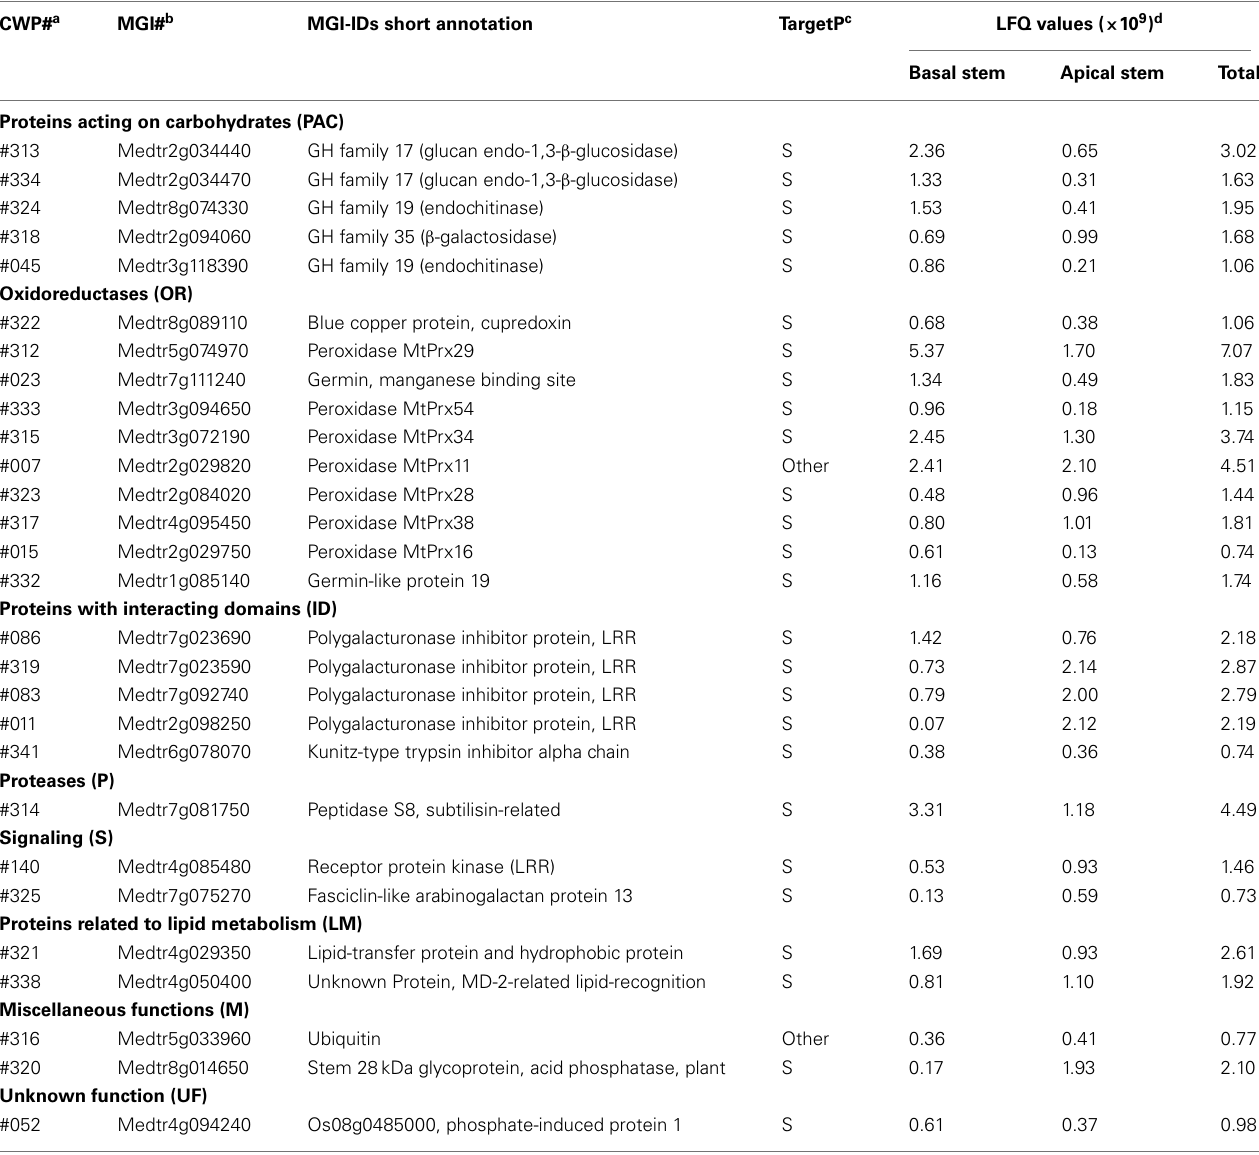
Table 1 |Abundant proteins identified in the EGTA and LiCl extracts of cell walls prepared from basal and apical alfalfa